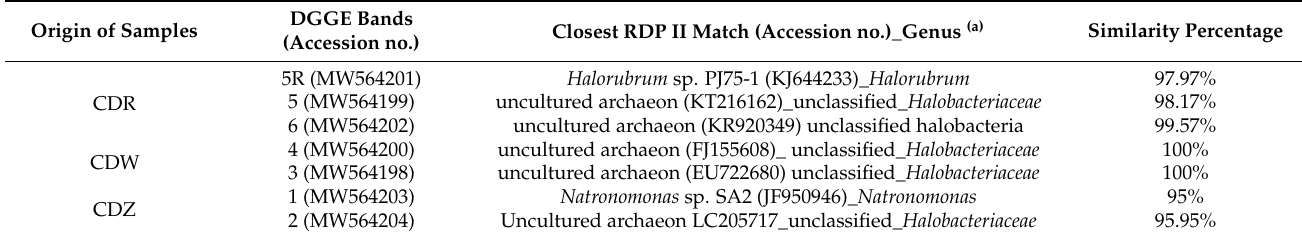
Table 2. Gene sequences (16SrRNA_V3) of related DGGE bands and their closest matches retrieved from RDPII database Origin of